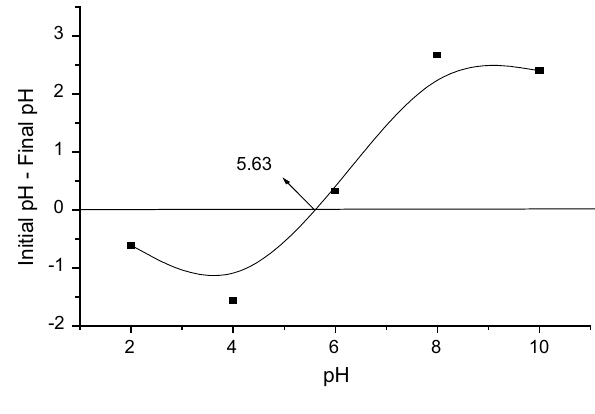
Fig. 1 ZPC of Banana peel